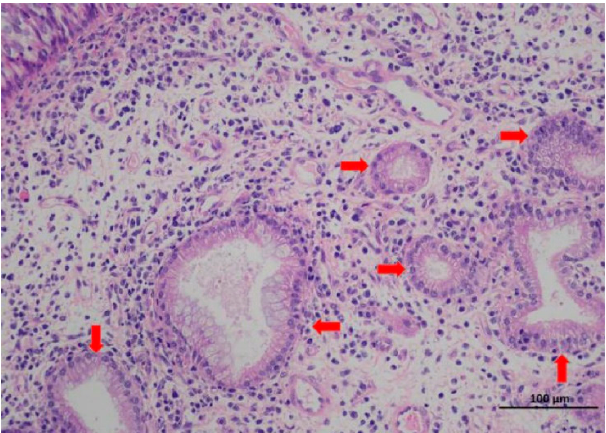
Figure 2. Microscopic feature of tumor tissues in goat 3. There were some different sizes of secretory glandular structures and a lot of interstitial epithelioid cells (labeled by the red arrows) in the figure (Bar = 100 μ m).